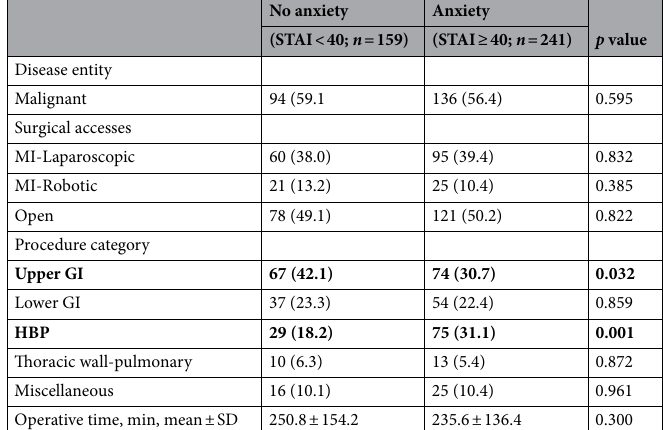
Table 2. Surgical variables ( N = 400). MI, minimally invasive; GI, Gastrointestinal tract; HBP, Hepato-Bilio- Pancreatic; min, minutes. Numbers in bracket indicate values presented in n (%). Significant values are in bold.